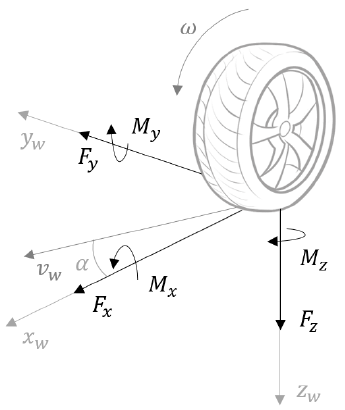
Figure 3. Schematics of a tire and generated forces and